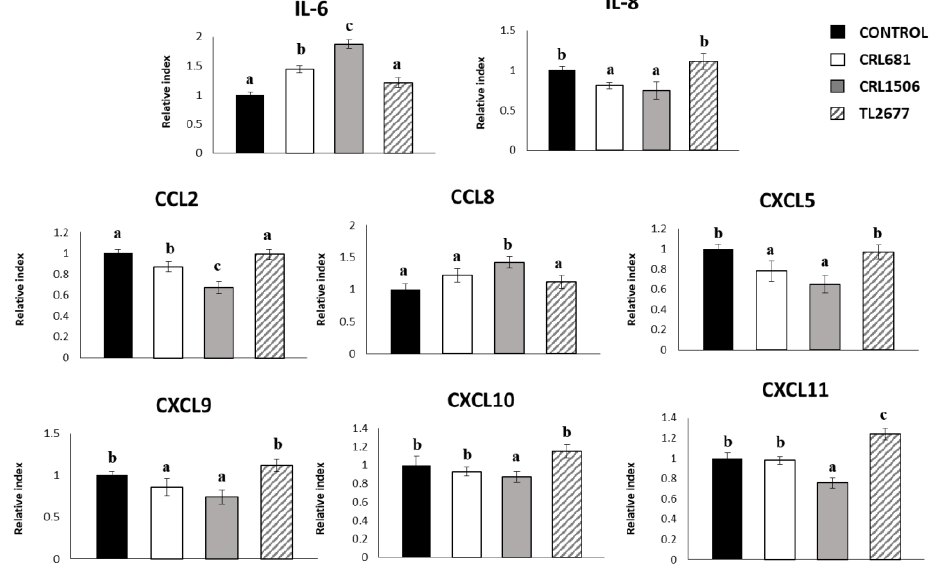
Figure 3. Effect of Lactiplantibacillus plantarum CRL681, CRL1506 or TL2677 on the expression of cytokines and chemokines in porcine intestinal epithelial (PIE) cells after Enterotoxigenic Escherichia coli (ETEC) challenge. PIE cells were pre-treated with CRL681, CRL1506 or TL2677strains for 48 h and then stimulated with heat-stable ETEC pathogen-associated molecular patterns (PAMPs). Non-lactobacilli treated cells were used as controls. The expression of cytokines (IL-6) and chemokines (CCL2, CXCL5, CXCL8, CXCL9, CXCL10, CXCL11, and CCL8) were studied at 12 h after heat-stable ETEC PAMPs challenge. The results represent three independent experiments. Results are expressed as mean ± SD. Bold letters indicate significant differences when compared to the control group ( p < 0.05).